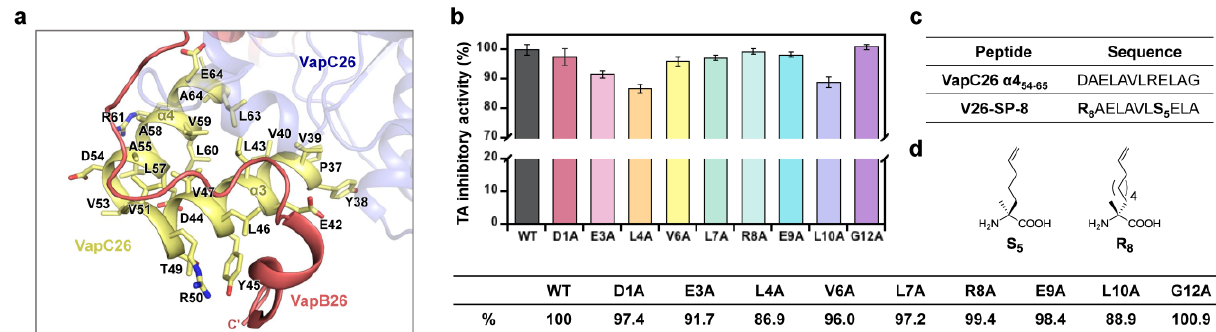
Figure 1. ( a ) X-ray crystal structure of the VapBC26 complex. The α-helical segments that are involved in the VapB26:VapC26 interaction are highlighted as follows: a binding interface in VapB26 (red) and VapC26 α3 37–52 and α4 54–65 (yellow). ( b ) Alanine scanning results of VapBC26-based linear peptides (VapC26 α4 54–65 ). The activity was normalized to that of the original peptides. The concentration of each peptide was 10 μM. Data are presented as the mean ± SD of three independent replicates. Average values are additionally denoted in the table. ( c ) Sequences of VapC26 α4 54–65 and its derivative V26-SP-8 . ( d ) Chemical structures of olefin-bearing noncanonical amino acids that were used for peptide stapling.